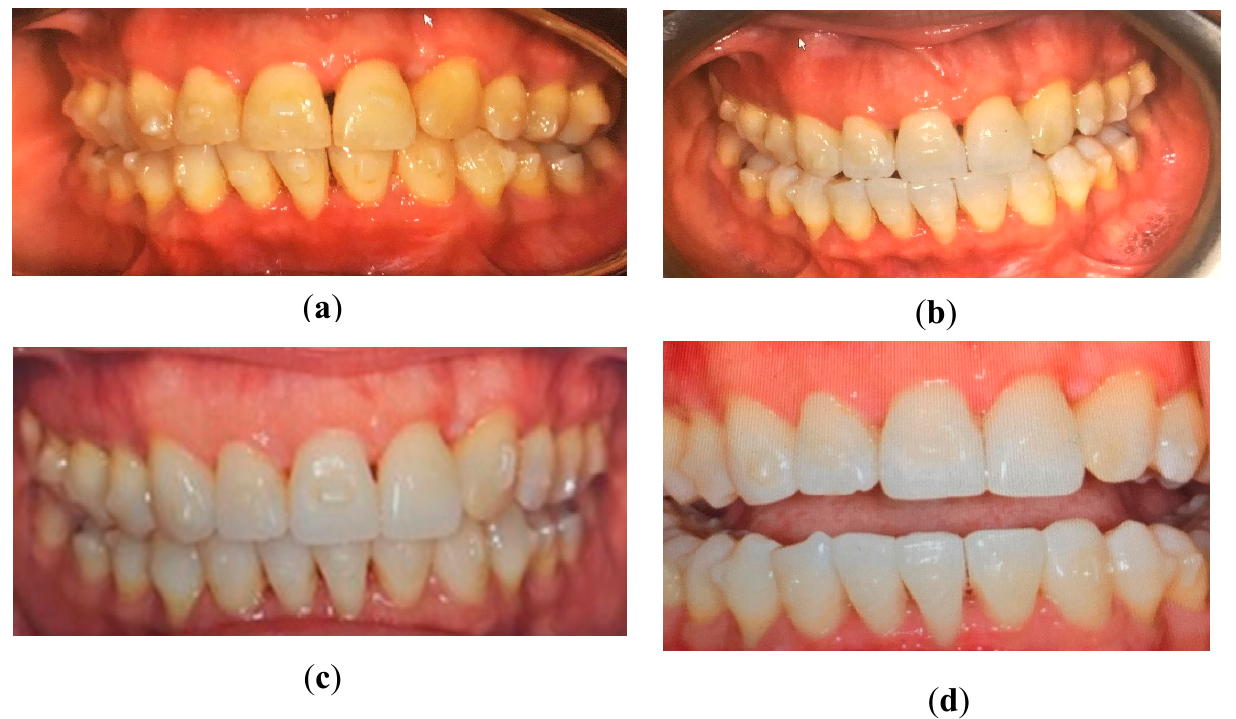
Figure 2. Patient representation at baseline ( a ), after 2 weeks ( b ) of bleaching teeth, after 4 weeks ( c ), and at 6 weeks post-op ( d ).